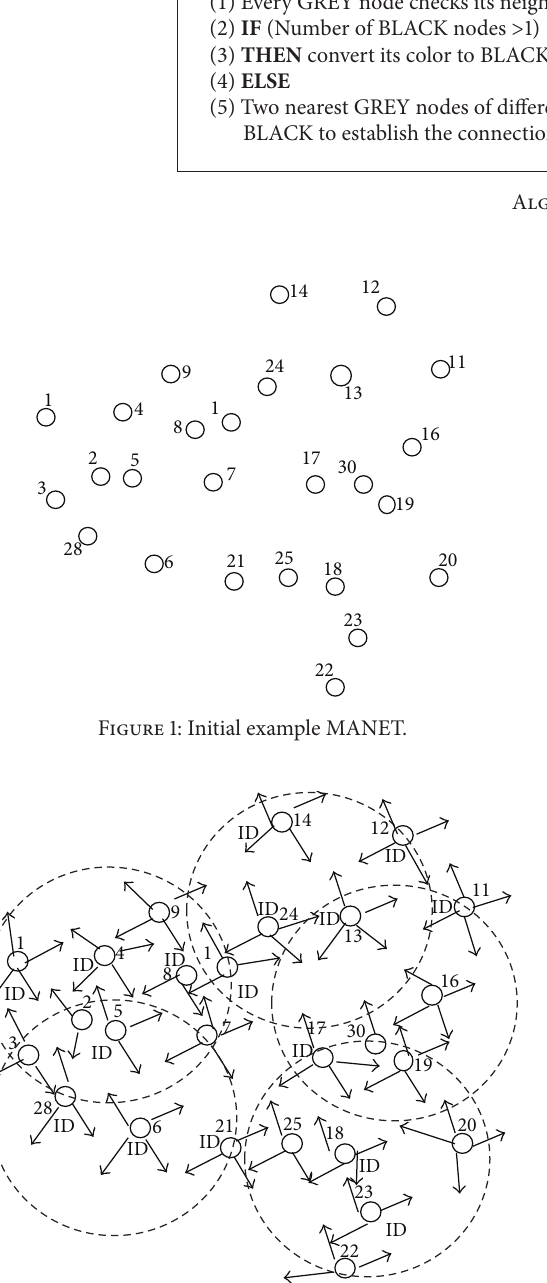
Figure 2: Initial MANET with ID exchange.